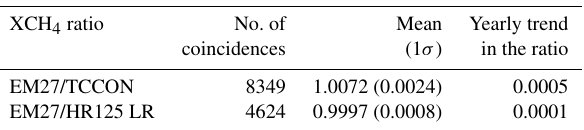
Table 4. XCH 4 biases between the EM27/SUN and HR125 data